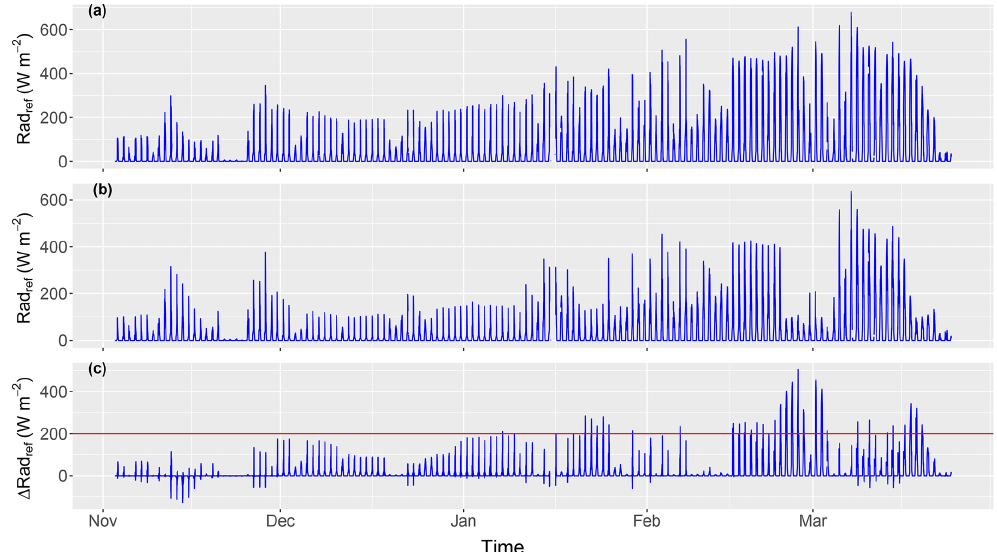
Figure 9. Results of measured reflected radiation (the whole 10min sampled data set) recorded in position a , the sensor above snow (a) , and b , the sensor above the snow-cleared area (b) , during the entire period of the experiment. Differences in reflected radiation recorded in position a and b ( (cid:49) Rad ref ) are shown in panel (c) , where the horizontal line represents the 200Wm − 2 threshold chosen to better discriminate the temperature differences from the overall uncertainty in temperature records. Negative values in panel (c) are mostly due to errors in radiation measurements being larger than the measurement values themselves, as shown in Fig. 7. The cluster of negative values reaching − 100Wm − 2 around 14 November happened before the first snow event, so these are not due to snow.